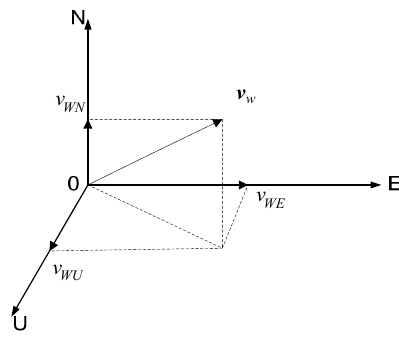
Figure 1. The components of the wind speed in the coordinate system E–N–U.